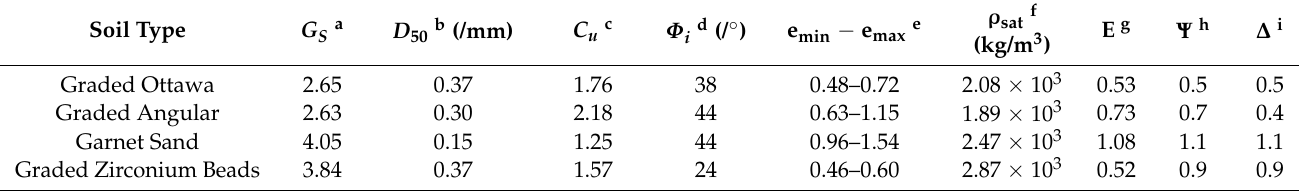
Table 1. Properties and characteristics of soils tested.